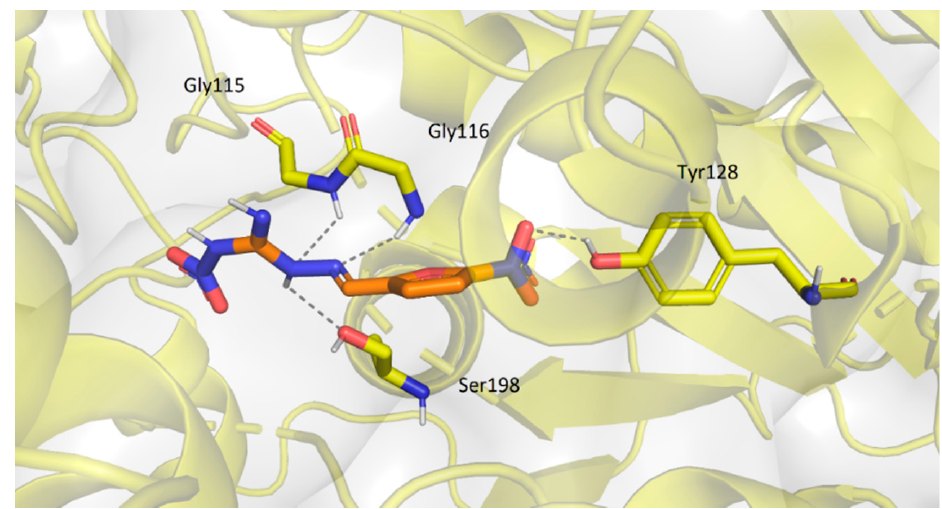
Figure 18. The binding mode of 3b (orange) in BuChE.